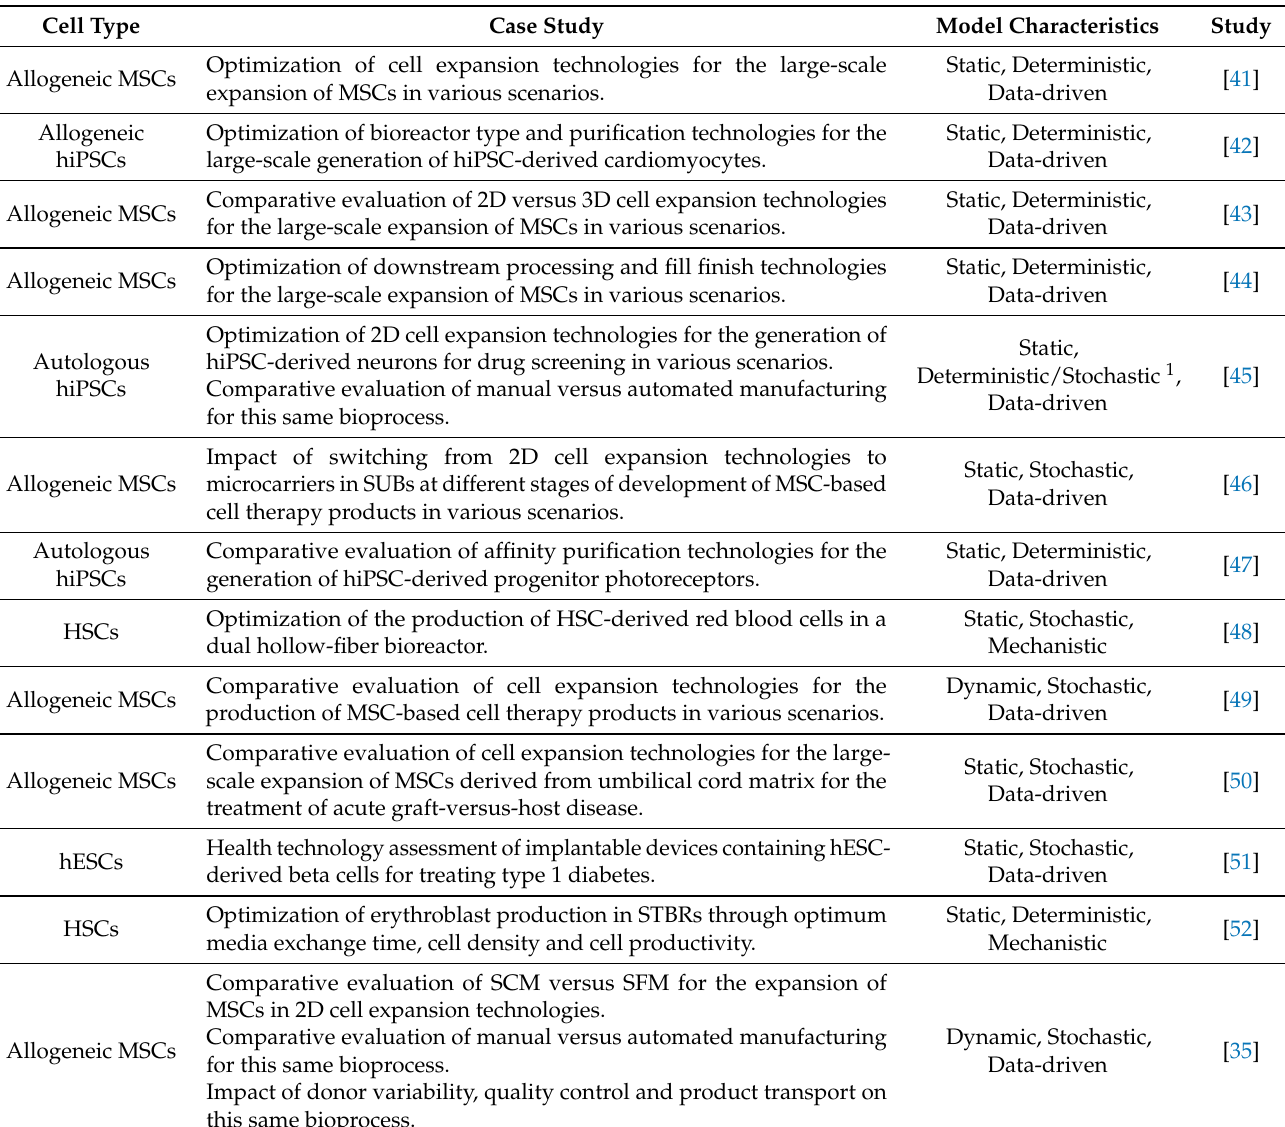
Table 2. Summary of studies which report stem cell-related bioprocess economic models. This list attempts to be comprehensive, covering multiple stem cell types, case studies with a diverse set of objectives and models with various combinations of the core characteristics previously described, but is not guaranteed to be entirely exhaustive. The works are listed in chronological